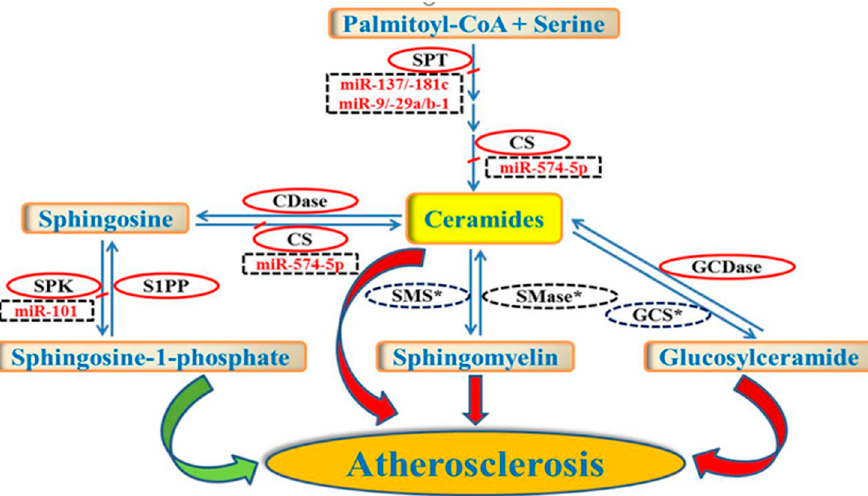
Figure 1. Schematic representation of miRNAs implicated in the synthesis of some key sphingolipid molecules. The figure is representative of some key enzymatic steps involved in sphingolipid biosynthetic pathways that are known to be regulated by various miRNAs (dotted rectangles). Enzymes with asterisks (dotted ovals) may be potential targets for other miRNAs that need to be identified. Increased levels of ceramides, sphingomyelin and glucosylceramide (red arrows) and decreased levels of sphingosine-1-phosphate (green arrow) have been implicated in atherosclerosis. The identification of novel miRNAs that regulate sphingolipid metabolism may be a potential therapeutic target to treat atherosclerosis. Abbreviations: SPT, serine palmitoyl transferase; CDase, ceramidase; CS, ceramide synthase; SPK, sphingosine kinase; S1PP, sphingosine-1-phosphate phosphatase; SMS, sphingomyelin synthase; SMase, sphingomyelinase; GCS, glucosylceramide synthase; GCDase, glucosylceramidase.